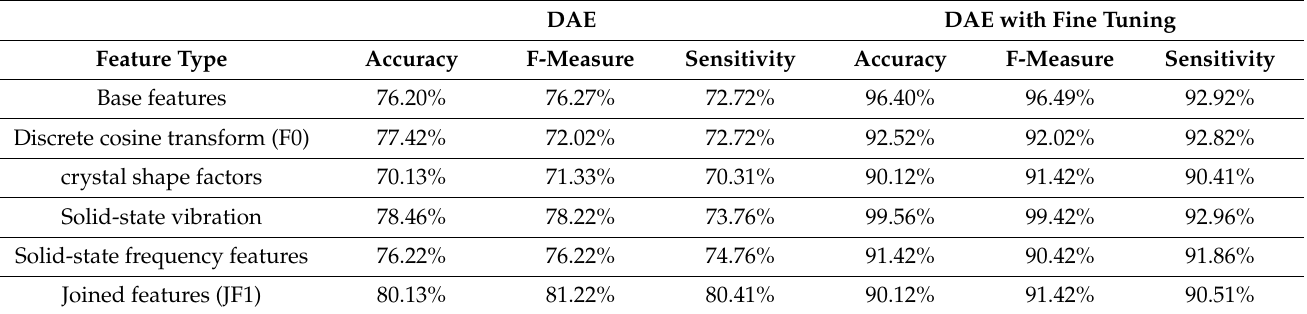
Table 7. Results of Single Feature Groups versus Joined features (JF1) that were the joining of base features, solid-state frequency and solid-state vibration tails for both the DAE and proposed models. DAE DAE with Fine